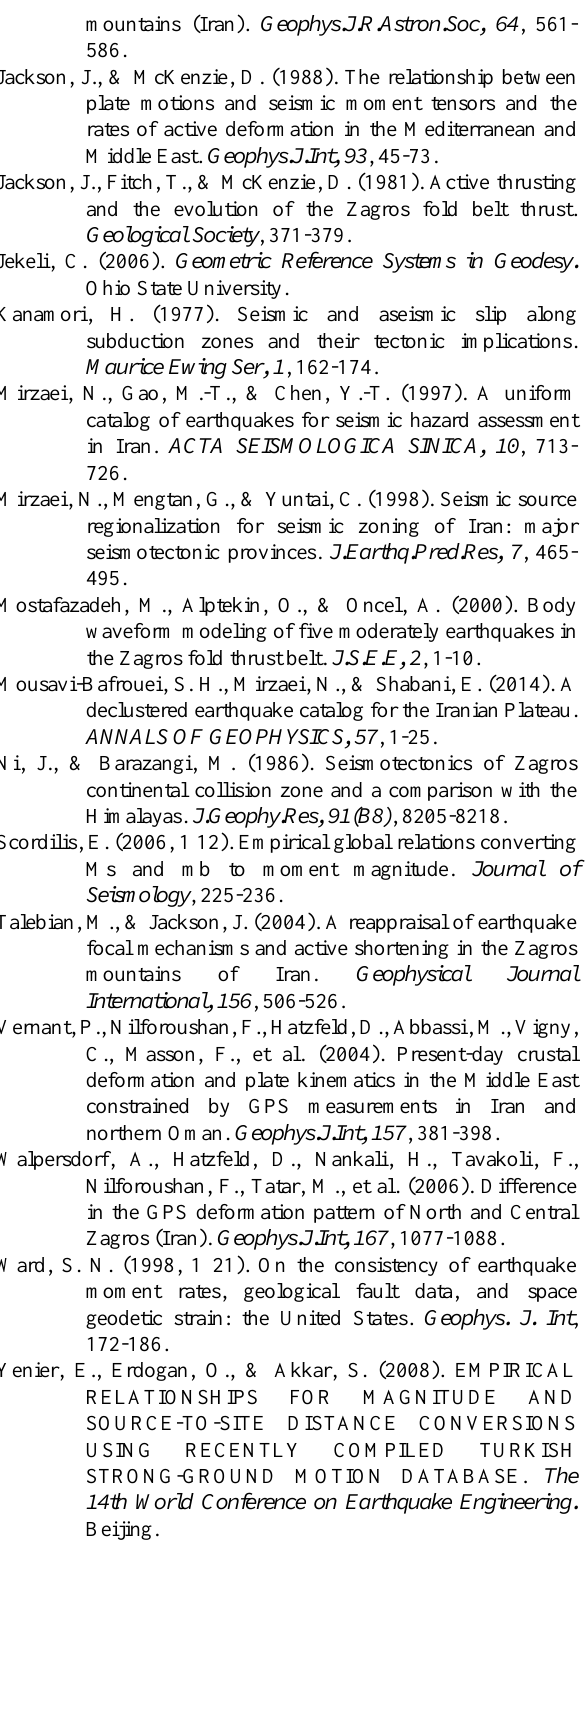
Figure 11. Density of the earthquakes with 5 